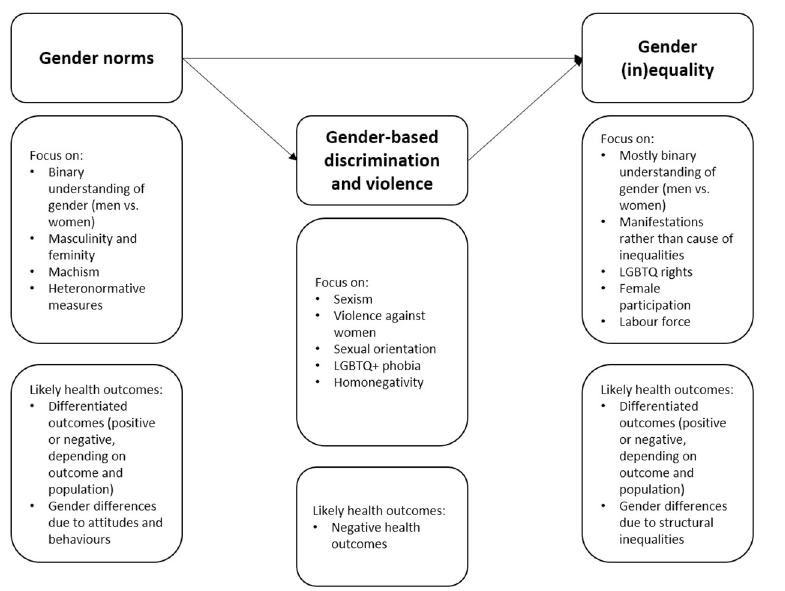
Fig 2. Categories and main characteristics of gender measures. Source: Authors’ own elaboration.